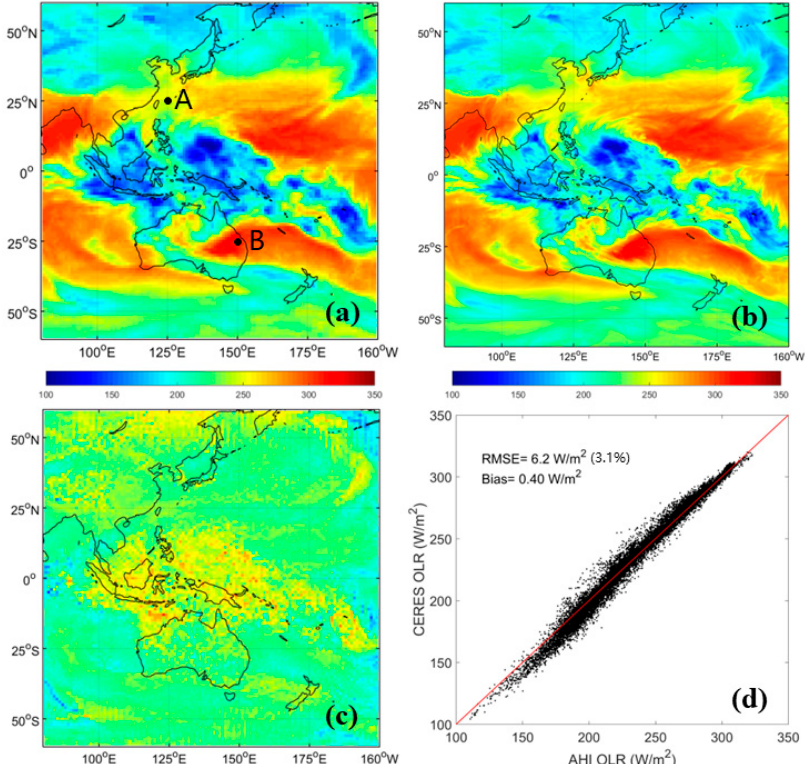
Figure 3. Daily TOA OLR on 1 February 2017. ( a ) CERES SYN OLR, ( b ) estimated AHI OLR, ( c ) differences between AHI and CERES OLR, and ( d ) comparison between AHI and CERES OLR.